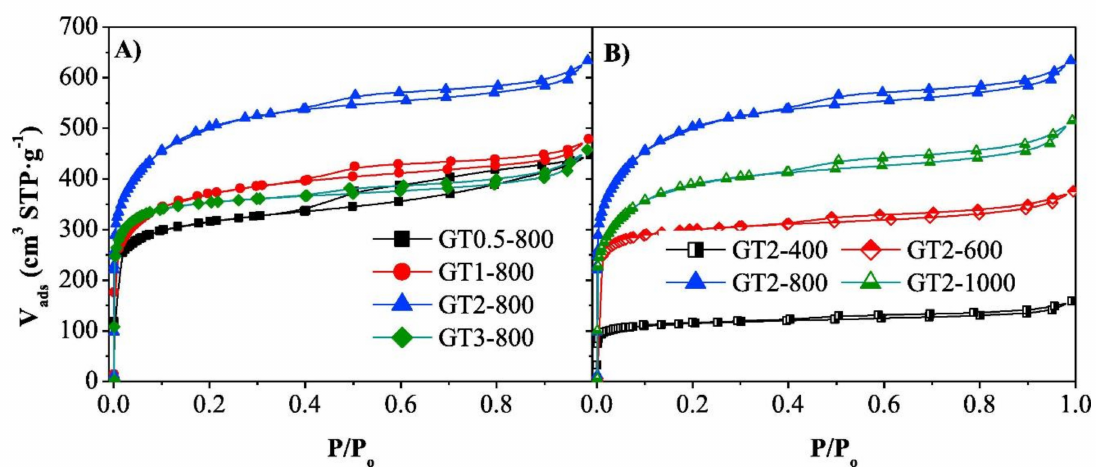
Figure 4. N 2 adsorption–desorption isotherms at − 196 ◦ C of the activated carbons prepared from Tara gum at ( A ) di ff erent impregnation ratios and 800 ◦ C and at ( B ) impregnation ratio of 2 and di ff erent activation temperatures (reprinted from [72] with the permission of Elsevier, 2018).